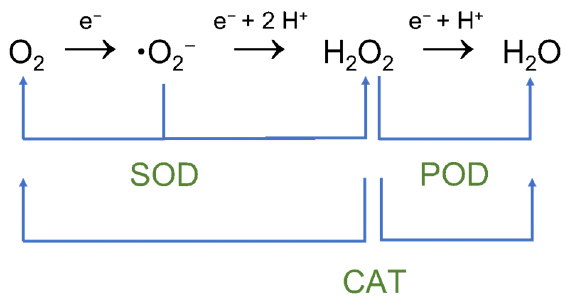
Figure 2. Schematic diagram of the reactions catalyzed by oxidoreductases mimicked by PB and PBA. SOD alternatively catalyzes the dismutation of superoxide into oxygen and hydrogen peroxide; POD breakdown hydrogen peroxide into the water; and CAT breakdown hydrogen peroxide into oxygen and water.